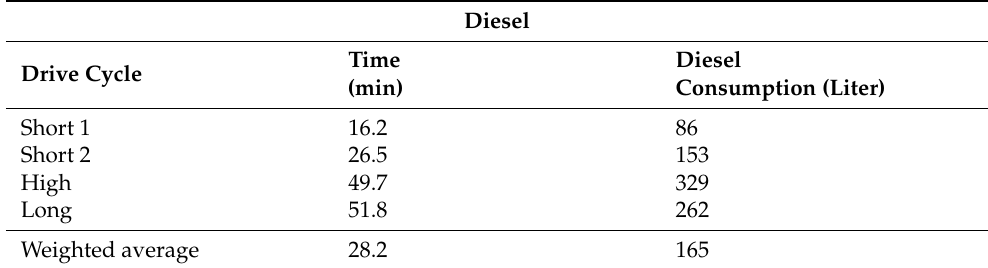
Table 3. Cycle time and fuel consumption for the drive cycles under pure diesel operation.